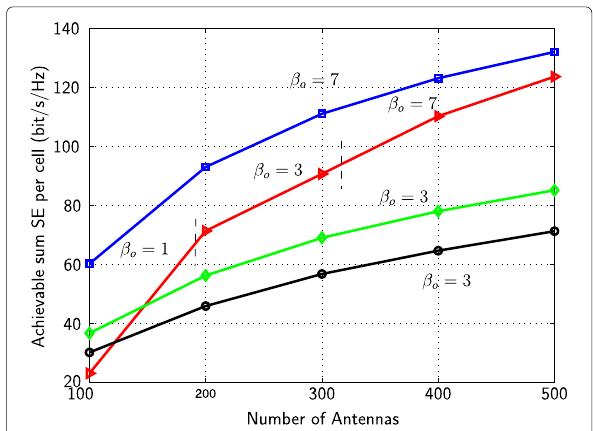
Fig. 5 Achievable sum SE of M-MMSE ( squares ), M-ZF ( triangles ), S-MMSE ( diamonds ), and MF ( circles ) with optimized β o ∈ { 1,3,4,7 } and K =